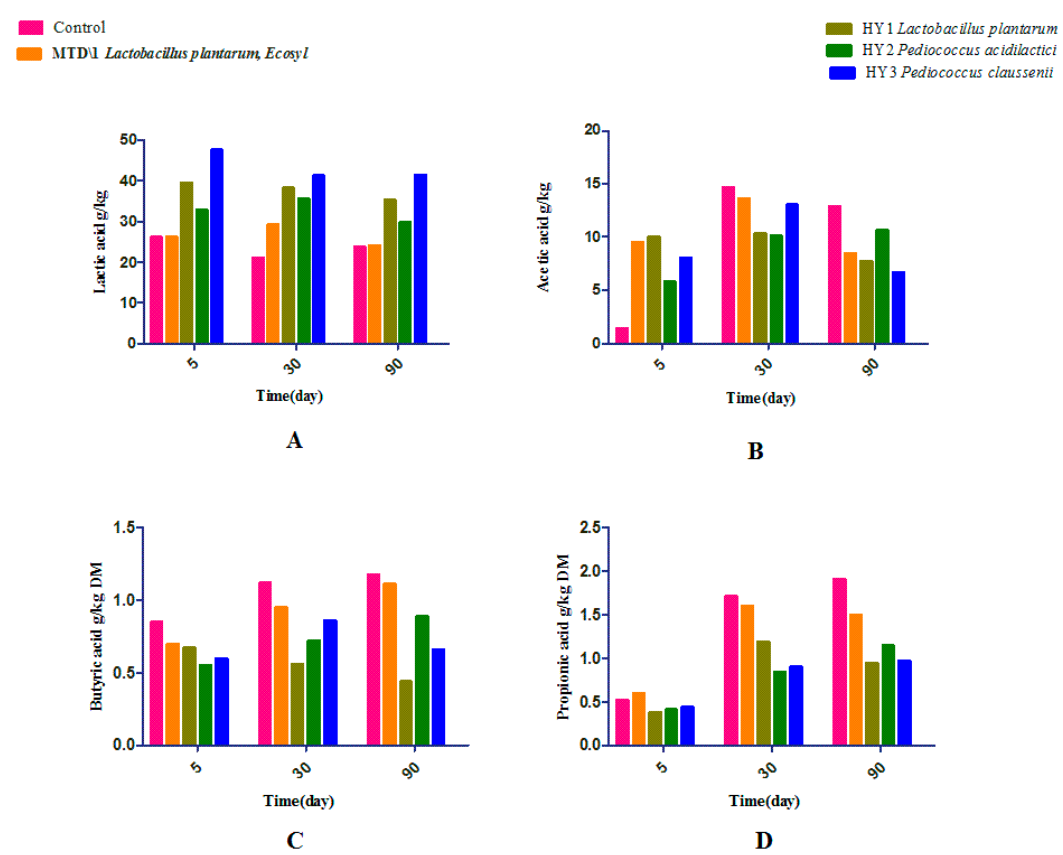
Figure 4. Effect of LAB inoculants on organic on sweet sorghum silage ( A ) lactic acid, ( B ) acetic acid, ( C ) butyric acid, ( D ) propionic acid during different opening times.